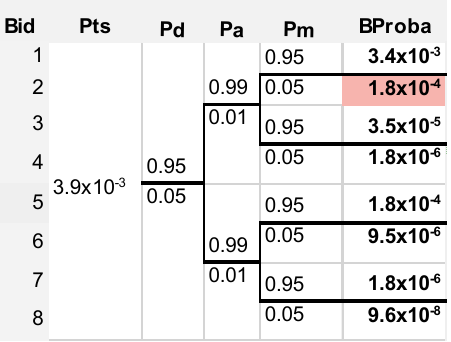
Figure 13. Event tree for the intrusion of an unauthorized drone in LIMC 17 departure path (<1 km from runway) when take-off is occurring.